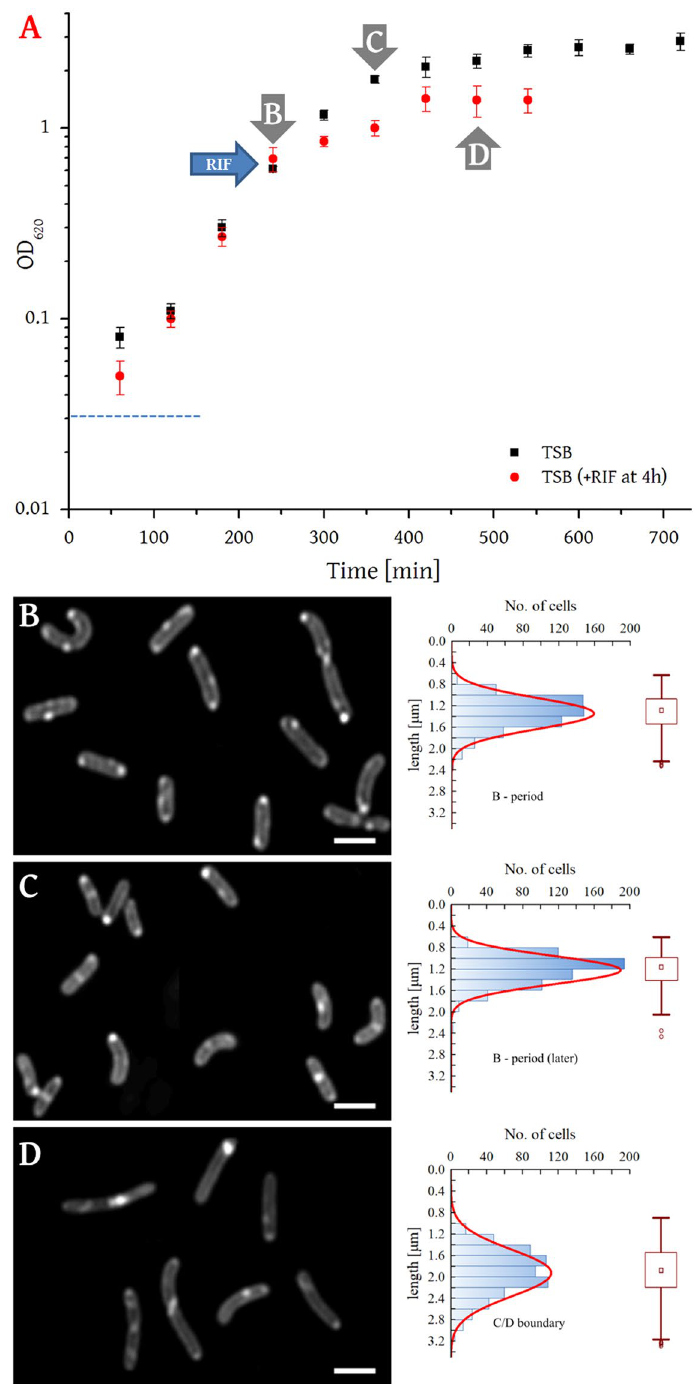
Figure 1. Identification of growth phases and image analysis of cultures. Panel A, Growth curve for L. innocua NCTC 11288 grown in TSB at 37 °C ( n = 3 independent experimental measurements per point). The lag phase lasted for approximately 150 min (------); exponential phase (untreated cultures) began at about 150 min and by 400 min the cells were in the stationary phase. In cultures treated with RIF, stationary phase was induced immediately although some growth was still detected for ~120 min. Samples in panels B and C (untreated controls) were collected after 240 and 360 min and sample in panel C was collected 240 min after RIF administration (at 480 min). Panels B–D show light and fluorescence micrographs of L. innocua ; for fluorescent imaging samples were stained with Nile red (1000 × magnification; scale bar = 1 µ m). A graph of the distribution of cell lengths is shown for each sample with Gaussian distribution (red line). Data represents 180–200 cells from at least three images from four independent cultivations. The Box plots show medians, 50% of data in the range (box), non-outliers range (whiskers) and outliers (circles and stars). Sample B is representative of cells in exponential phase growth (240 min after inoculation) with the majority of cells appearing to be in the B period ( > 80% synchrony; mean = 1.34 µ m, ± 0.29 µ m). Sample C